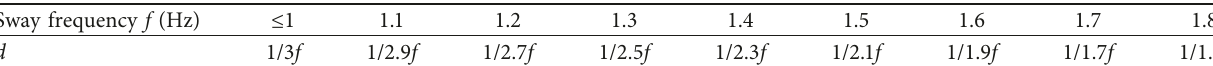
Figure 3: The single swaying load. Table 2: The value of parameter d .